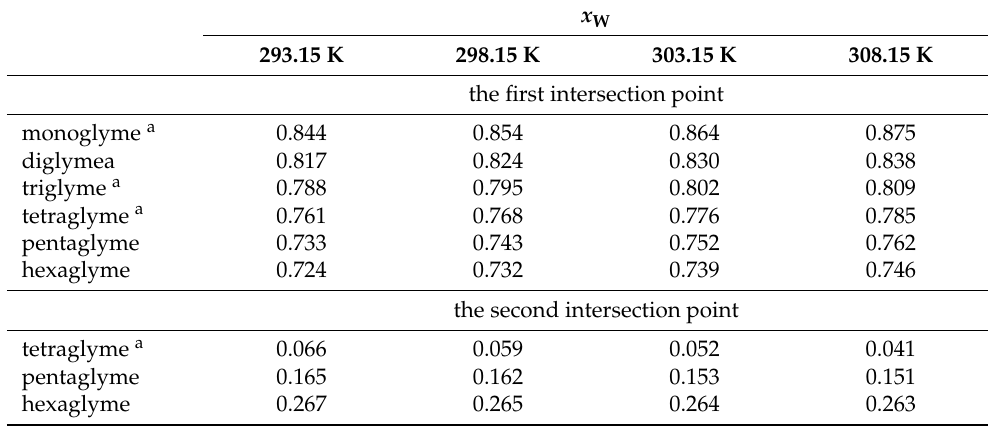
Table 4. The mole fraction of water ( x W ) in the DMF + W mixed solvent corresponding to the intersection point of the functions κ S = f ( x W ) for the glymes at 298.15